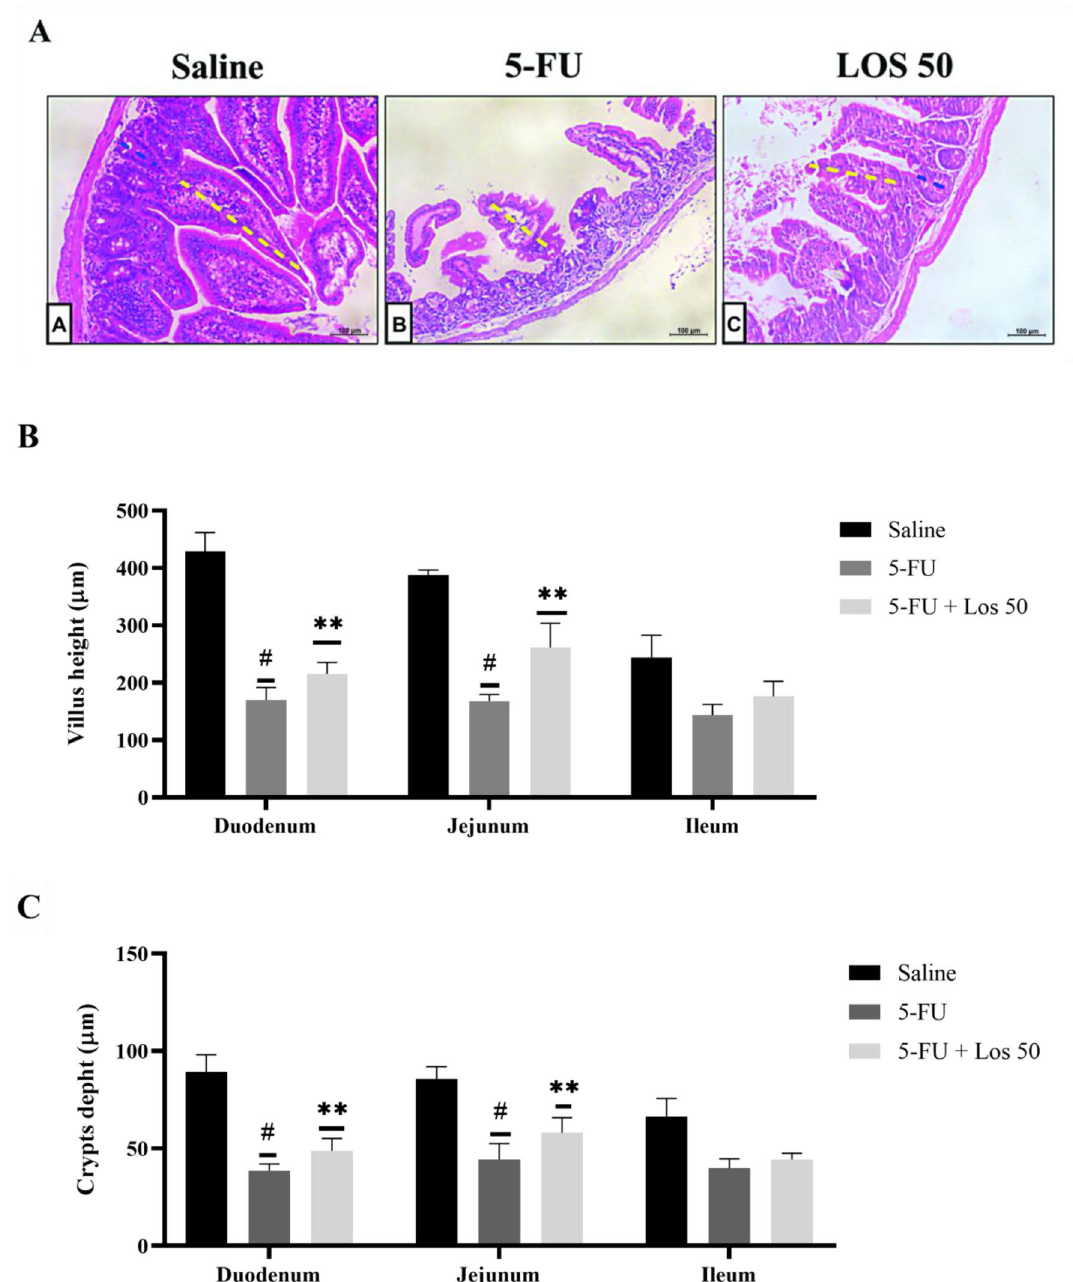
Figure 2. ( A ) Images of histological slides stained in H&E, of fragments of the jejunum of mice submitted to intestinal mucositis. Animals saline without IM (a), with intestinal mucositis induced by 5-FU, without treatment (b) and animals with IM, treated with losartan at a dose of 50 mg/kg. The measurement of villus integrity is represented by dashed lines in yellow and the size of crypts is represented by dashed lines in blue. Segments of the duodenum, jejunum and ileum were collected to measure the villus height (10 villi/lamina). Scale bars = 100 µm ( B ) and crypt depth measurements ( C ). The bars represent the mean ± SEM of 5 mice in each group. # p < 0.001 vs. saline group, **p < 0.001 vs. 5-FU group. One way ANOVA with Bonferroni quality of life and diet, leading to weight loss and may compromise the delivery of cancer therapy and the overall prognosis 28–30 . Losartan (LOS) at a dose of 50 mg/kg prevented the histopathological and morphometric changes induced by 5-FU in the jejunum and colon. In addition, LOS 50 mg/kg partially rescued the animals’ weight loss induced by 5-FU-induced intestinal mucositis. Losartan is an angiotensin II AT1 receptor blocker. Although the main role of the renin-angiotensin system (RAAS) in the cardiovascular and renal systems, it has been described differ- ent subtypes of angiotensin receptors in the mucosal and muscular layers of the intestine, regulating intestinal